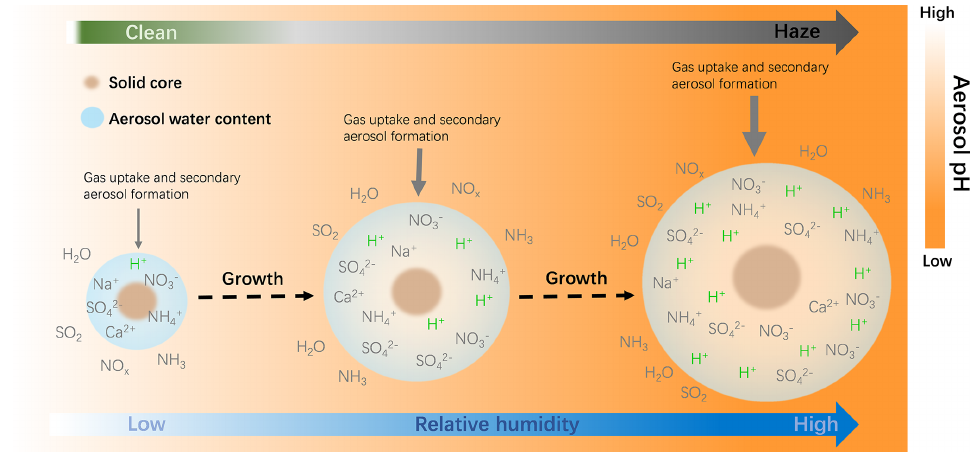
Figure 11. The schematic plot of the temporal evolution of PM 2 . 5 pH during the haze cycle in Beijing. The size of blue circles indicates the relative amount of aerosol water, and the thickness of downward arrows indicates the relative strength of the